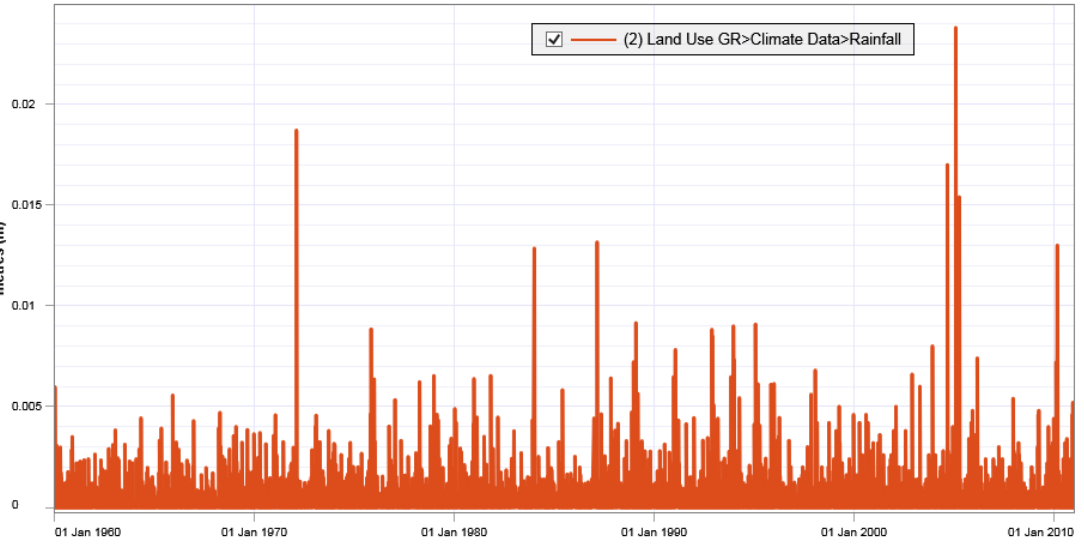
Figure 5. The 6 min rainfall data during the study period from 1 January 1960 to 31 December